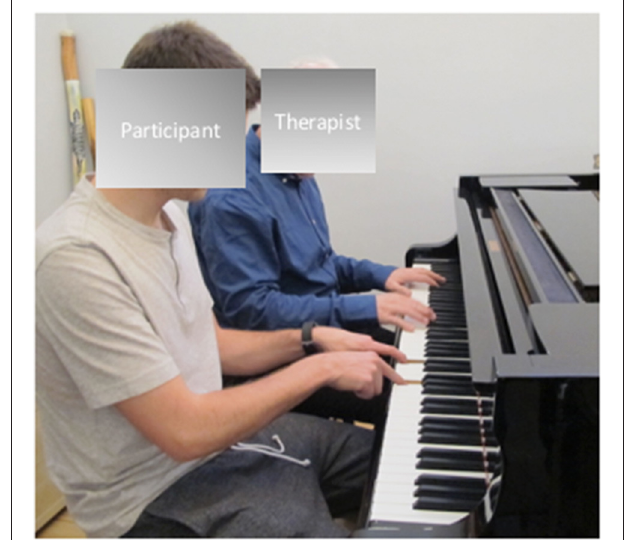
the left side of the keyboard, and the participant, toward the right side of the keyboard (when looking from behind